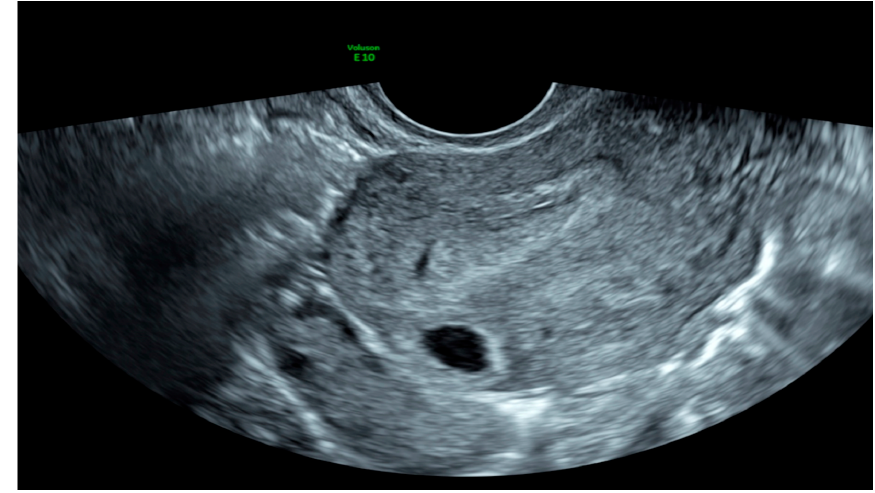
Figure 3. 2D Transvaginal image of an interstitial ectopic pregnancy. The empty uterine cavity, the myometrial layer of less than 5 mm surrounding the GS, a chorionic sac separated and laterally located >1 cm from the sideward portion of the uterine cavity, the visualization of the interstitial line between the GS and the lateral edge of the endometrial cavity and the myometrial mantle around the ectopic GS.